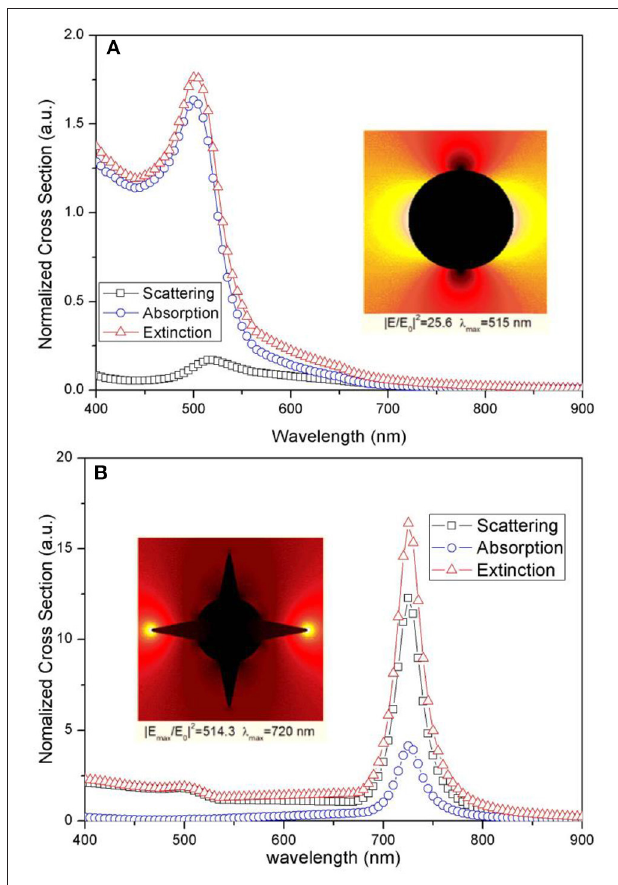
FIGURE 3 | LSPR spectra for Au nanosphere (A) and nanostar (B) . Inserted images in (A) and (B) correspond to the cross-sectional views of Au nanosphere and Au